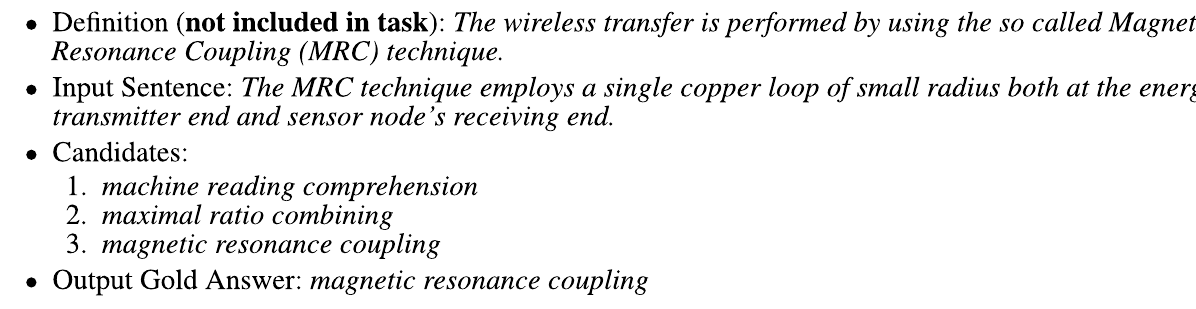
FIGURE 4 | An example of the AD (Acronym Disambiguation) Task. The system is asked to return one of the candidates. This task would be easier (and more realistic) with more context (including de fi nitions). Input sentences were selected from arXiv. This example comes from https://arxiv.org/pdf/1805.07795.pdf, where the de fi nition appears immediately before the input